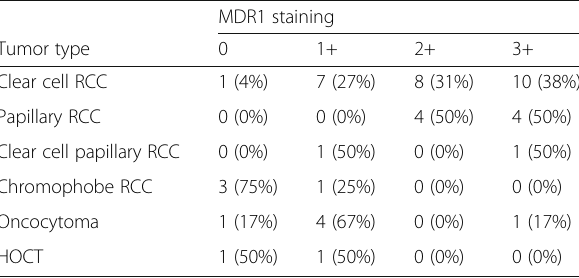
Table 2 Semi-quantitative immunohistochemical staining for MDR1 stratified by tumor type MDR1 staining